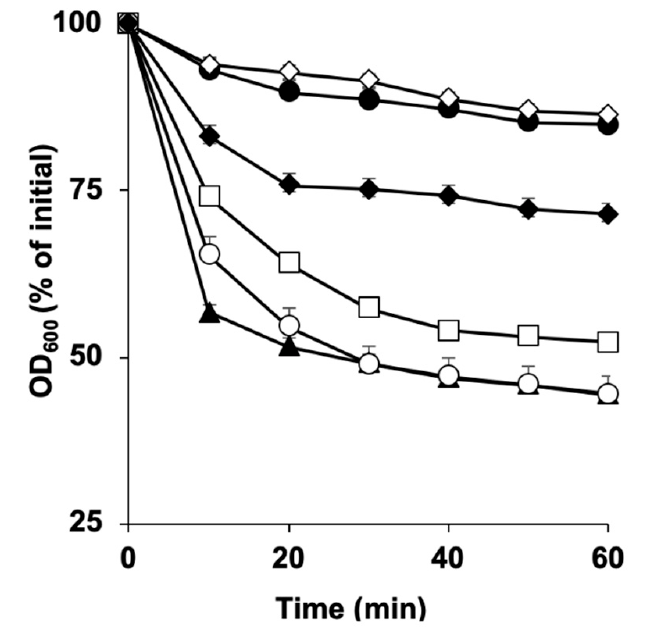
Figure 4. Germination of C. perfringens SM101 spores in the presence of Ca 2+ and a specific Ca 2+ chelator (EGTA). Heat-activated spores were incubated for 60 min at 37 °C with 50 mM Tris-HCl buffer (pH 6.0) (filled circles), 100 mM KCl (filled triangles), 50 mM EGTA-100 mM KCl (open cir- cles), 50 mM CaCl 2 (open squares), 50 mM EGTA-CaCl 2 + 100 mM KCl (filled diamonds), and 50 mM CaCl 2 -EGTA (open diamonds). Then, the OD 600 was measured at various time points. Error bars are the standard deviations from the means of at least duplicate experiments with two independent spore preparations.